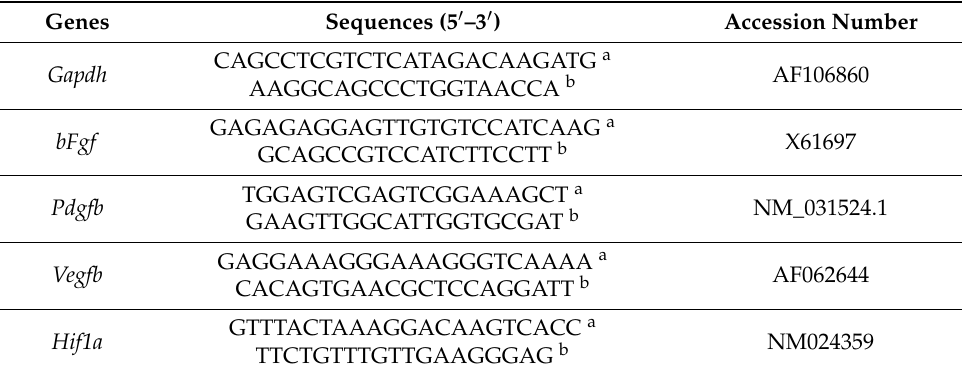
Table 1. Oligonucleotide primers used in this study.